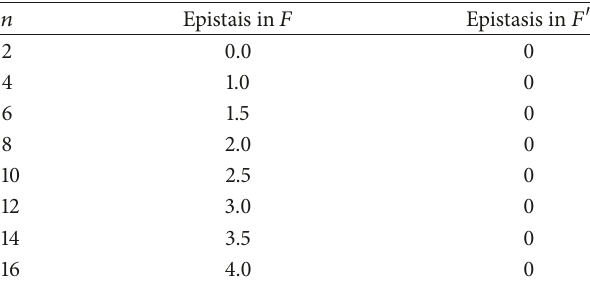
Table 1: Epistasies of evaluation functions 𝐹 and 𝐹 󸀠